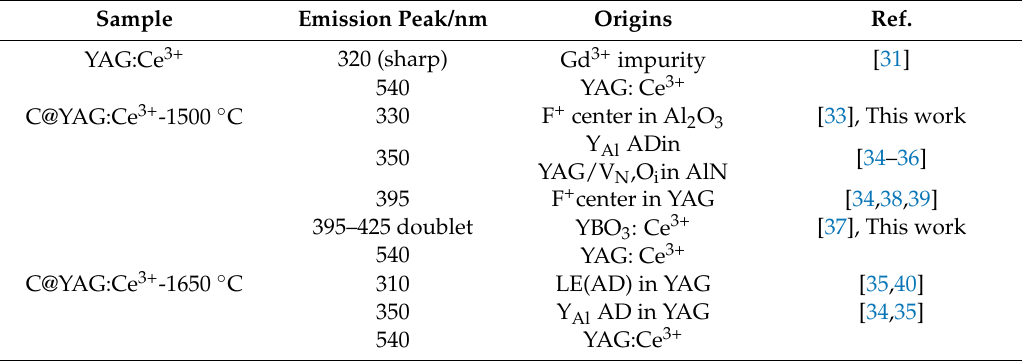
Table 1. Overview of the emission peaks and their possible origins in YAG:Ce 3+ ,C@YAG:Ce 3+ -1500 ◦ C, and C@YAG:Ce 3+ -1650 ◦ C